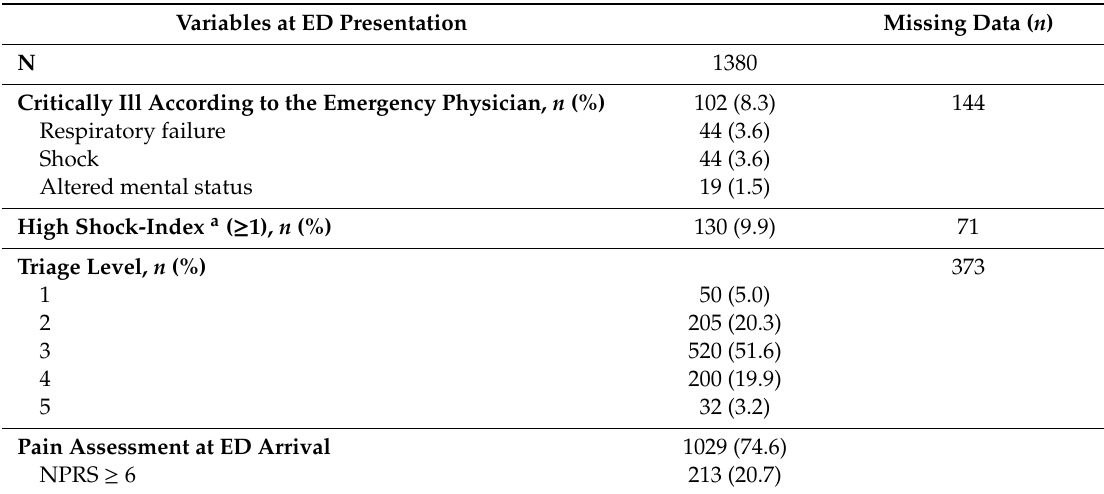
Table 3. Clinical severity of cancer patients upon emergency department